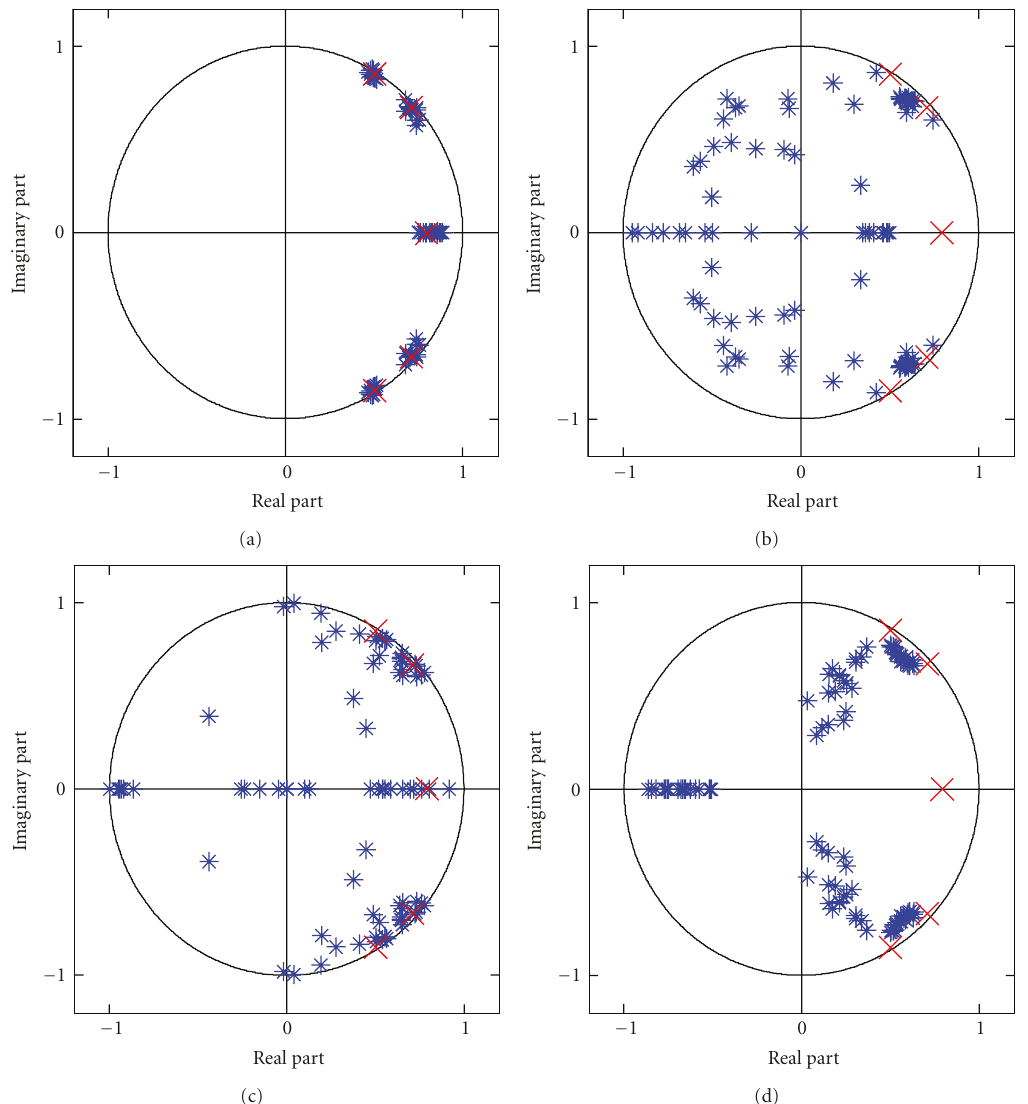
Figure 2: Superimposed pole plot of AR(5) system at SNR = − 5 dB. × : true poles and ∗ : estimated poles. (a) Proposed, (b) ILSF, (c) SSYW, and (d) MLSYW